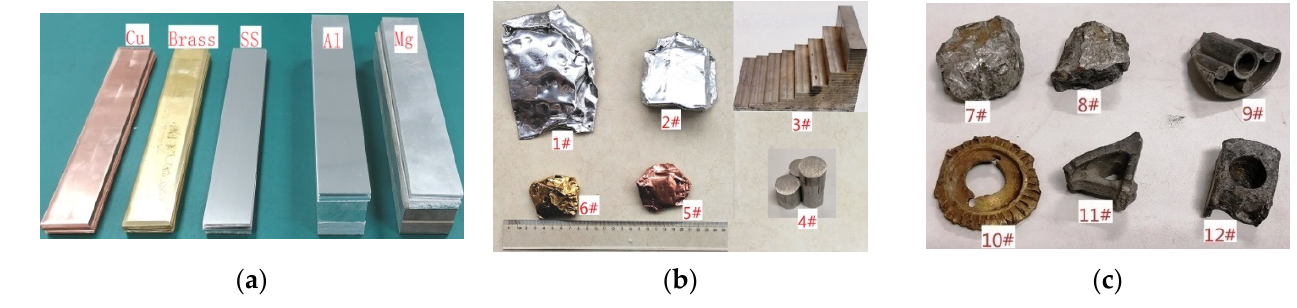
Figure 3. ( a ) Calibration samples. ( b ) Self-made samples. ( c ) Waste samples.